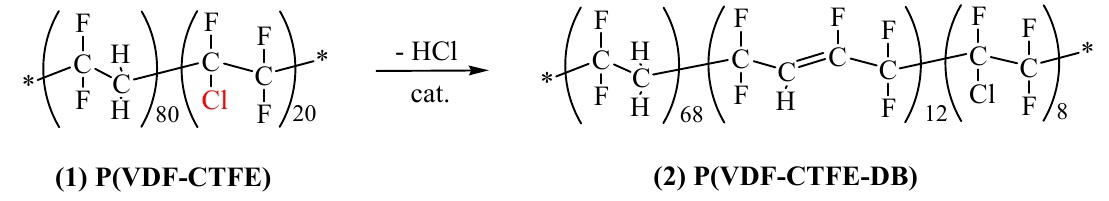
Figure 2. 1 H-NMR spectra of P(VDF-CTFE) (Line 1) and P(VDF-CTFE-DB) (Line 2).